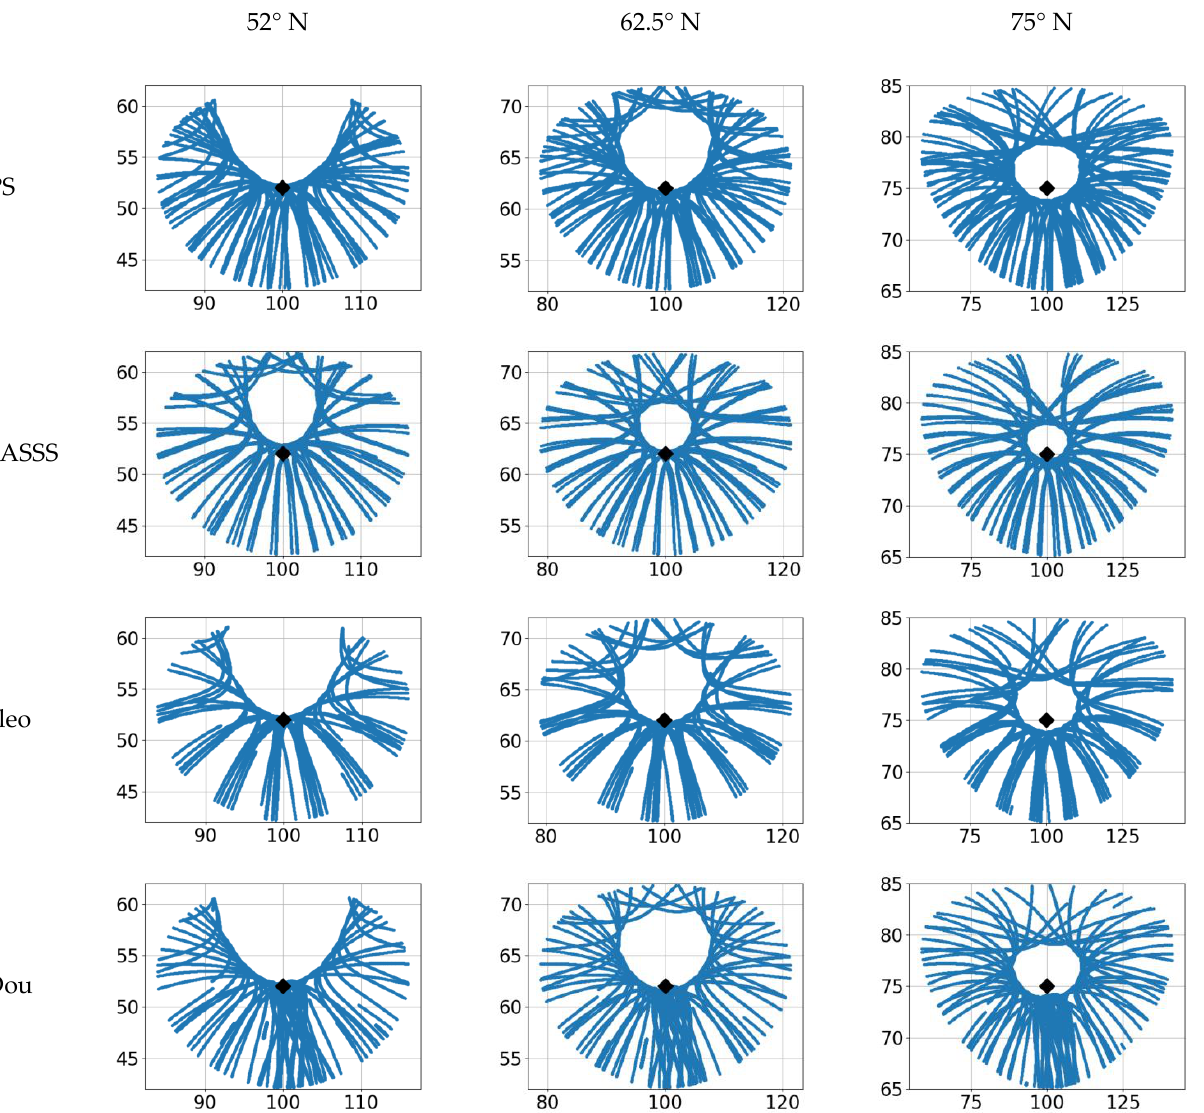
Figure 9. Diurnal ionospheric points for GPS, GLONASS, Galileo, BeiDou (top to bottom). The rhomb marks the station position. The station longitude is 100° E. Left column: at 52.2° N, mid column: at 62.5° N, right column: at 75° N.